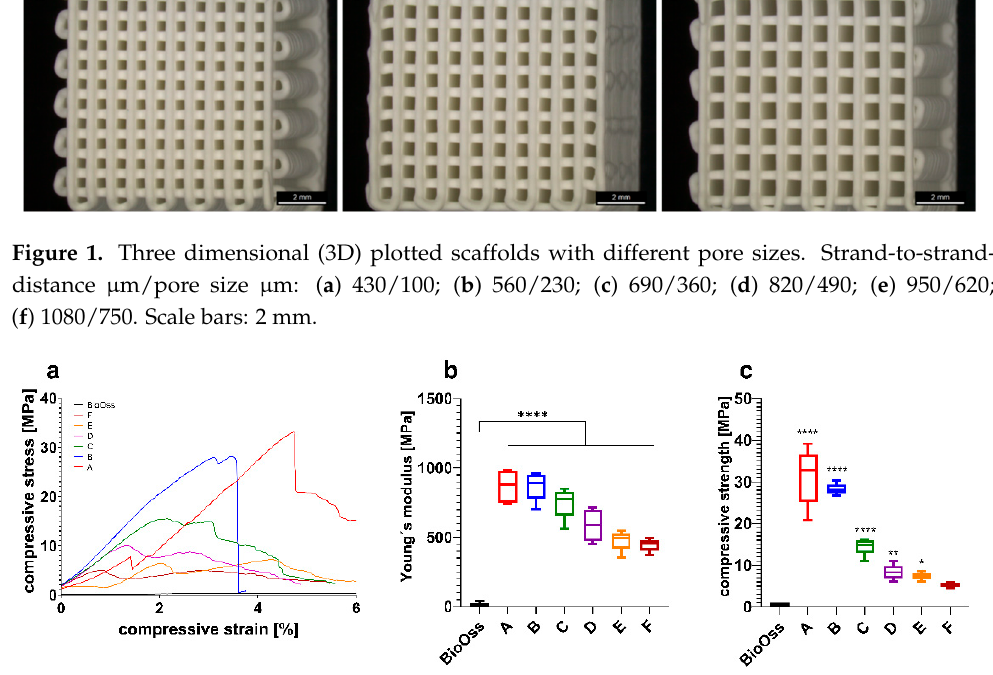
Figure 2. Mechanical properties of CPC scaffolds A–F (see also Table 1) with different pore sizes in comparison to BioOss ® . ( a ) Representative compressive stress–strain curves. ( b ) Young’s modulus and ( c ) compressive strength determined from the curves (* p ≤ 0.05, ** p ≤ 0.01, *** p ≤ 0.001, **** p ≤ 0.0001, mean ± standard deviation, n = 5). Table 1. Mechanical properties of 3D printed scaffolds A–F with different strand-to-strand distances and pore sizes and control.